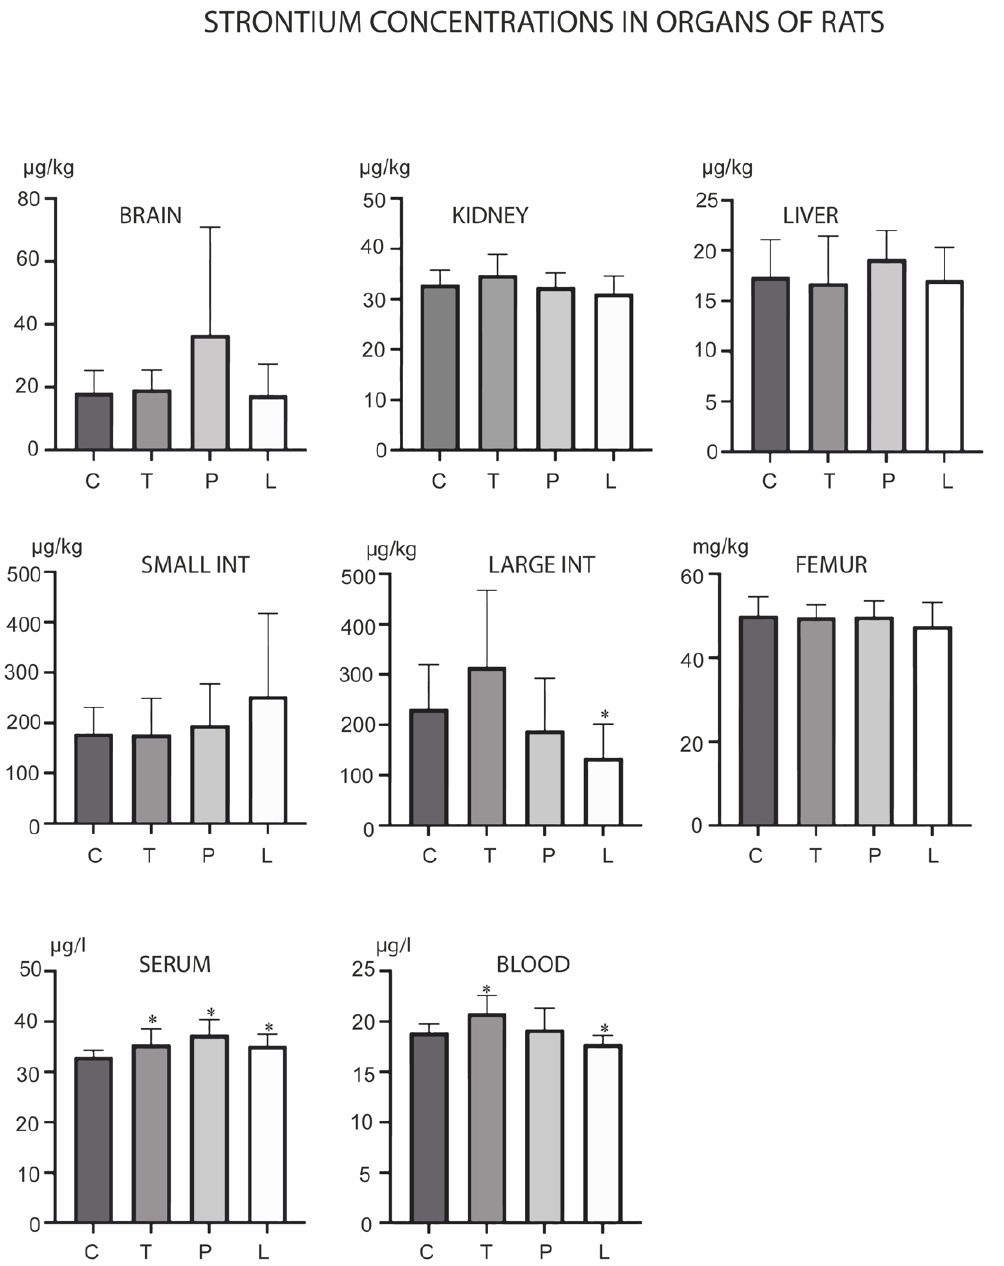
Figure 7. Concentrations of strontium in the brain, kidney, liver, small intestine, large intestine, serum, blood and femur after the three-month oral administration of silicates. C denotes the control group; T denotes the experimental group receiving TMAZ; P denotes the experimental group receiving PMA; and L denotes the experimental group receiving Ludox silica. Asterisk (*) denotes significant differences between the experimental groups, with control at p < 0.05.